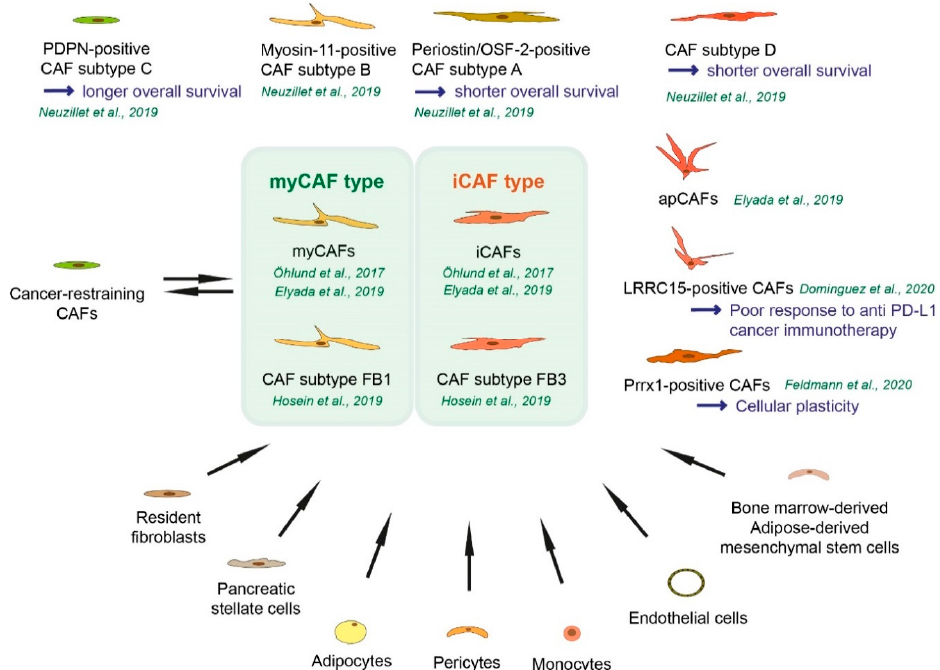
Figure 1. Origin and functional heterogeneity and classification of cancer-associated fibroblasts.